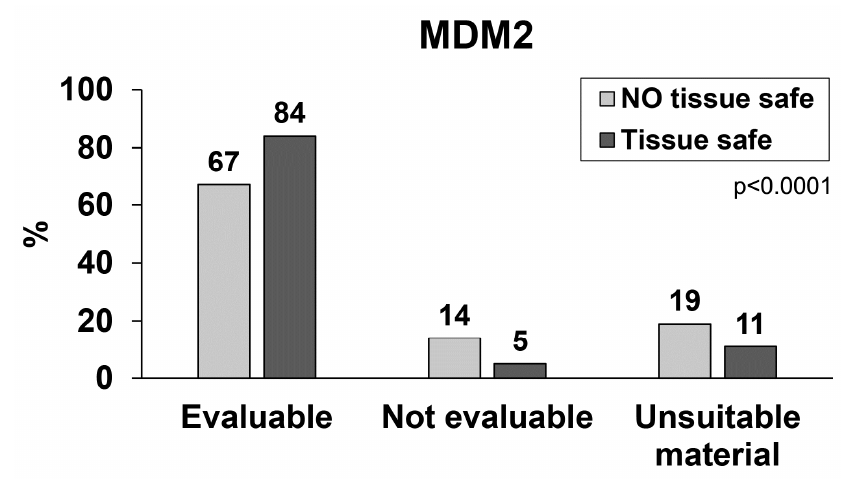
Figure 3. Evaluation of the analytical quality of samples analysed for the state of the MDM2 gene by FISH on tissue stored and transported in a traditional way involving the use of formalin solution (light grey bars) vs. sealing tissue specimen under vacuum in plastic bags (dark grey bars). p value refers to the differences in the analytical quality (evaluable, not evaluable and unsuitable material) between the two groups. Table 2. Sensitivity and specificity of the molecular analyses in the diagnosis of different subtypes of